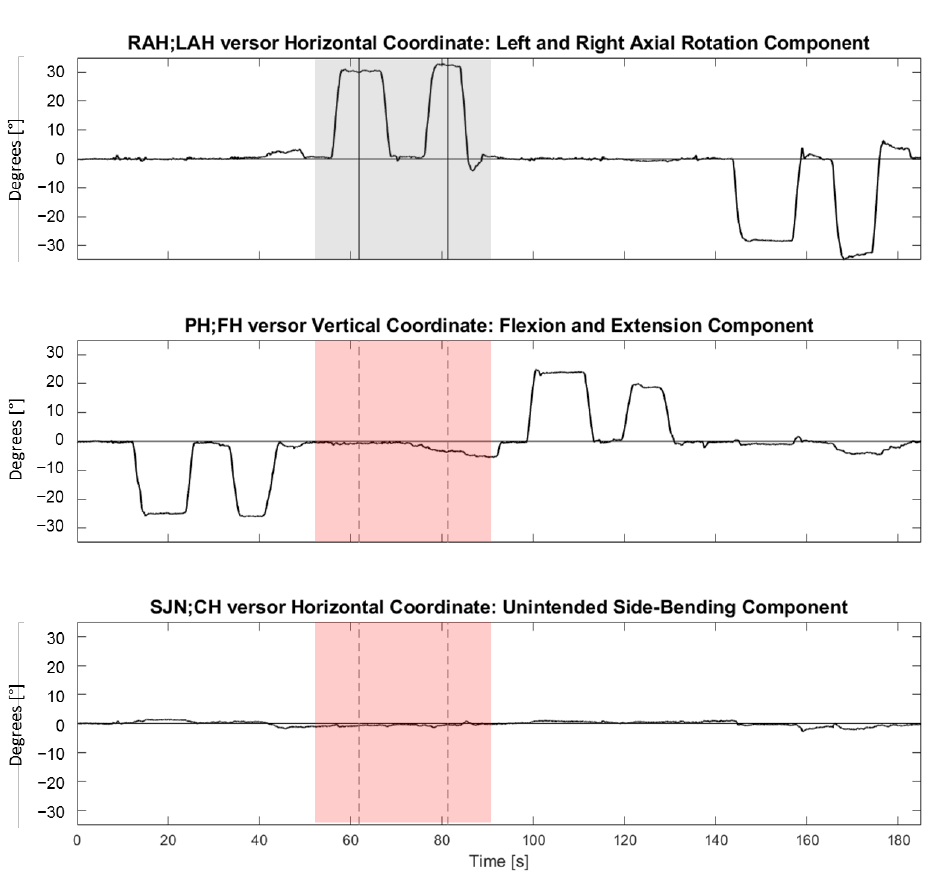
Figure 4. Representative synchronous tracings of the time course of the angles between 𝑹𝑨𝑯; 𝑳𝑨𝑯⃗⃗⃗⃗⃗⃗⃗⃗⃗⃗⃗⃗⃗⃗⃗⃗⃗⃗⃗⃗⃗⃗ , 𝑷𝑯;𝑭𝑯⃗⃗⃗⃗⃗⃗⃗⃗⃗⃗⃗⃗⃗⃗⃗⃗ , and 𝑺𝑱𝑵;𝑪𝑯 ⃗⃗⃗⃗⃗⃗⃗⃗⃗⃗⃗⃗⃗⃗⃗⃗⃗⃗ versors and the Neutral Head Position during four consecutive trials (i.e., flexion, followed by right rotation, extension, and left rotation). From top to bottom, horizontal 𝑹𝑨𝑯;𝑳𝑨𝑯⃗⃗⃗⃗⃗⃗⃗⃗⃗⃗⃗⃗⃗⃗⃗⃗⃗⃗⃗⃗⃗⃗ (referring to right and left neck rotations), vertical 𝑷𝑯;𝑭𝑯⃗⃗⃗⃗⃗⃗⃗⃗⃗⃗⃗⃗⃗⃗⃗⃗ (referring to neck flexion and extension), and horizontal 𝑺𝑱𝑵;𝑪𝑯 ⃗⃗⃗⃗⃗⃗⃗⃗⃗⃗⃗⃗⃗⃗⃗⃗⃗⃗ (referring to neck right and left side-bending) coordinates are shown. On the ordinate, coordinates are expressed in angular degrees (°). On the abscissa, time is reported (in seconds). The vertical lines indicate time events manually identified during the analysis for a right rotation movement. The grey-shaded area highlights the intended component (horizontal coordinate) during a right rotation trial. The pink-shaded areas highlight the synchronous unintended components of flexion-extension and side-bending in the second and third panels from the top, respectively. For each trial, two repetitions were performed in the same direction (an operator-assisted repetition, followed by an autonomous repetition). For each repetition, a plateau in the tracings was manually identified. The TP or the RP corresponded to the mean, computed over two seconds, of the versor trace in the mid of the plateau (vertical segments). If more plateaus were present, the furthest plateau from the ideal target (for TP) or from the TP (for RP) was considered. Student’s t -tests were used as post-hoc